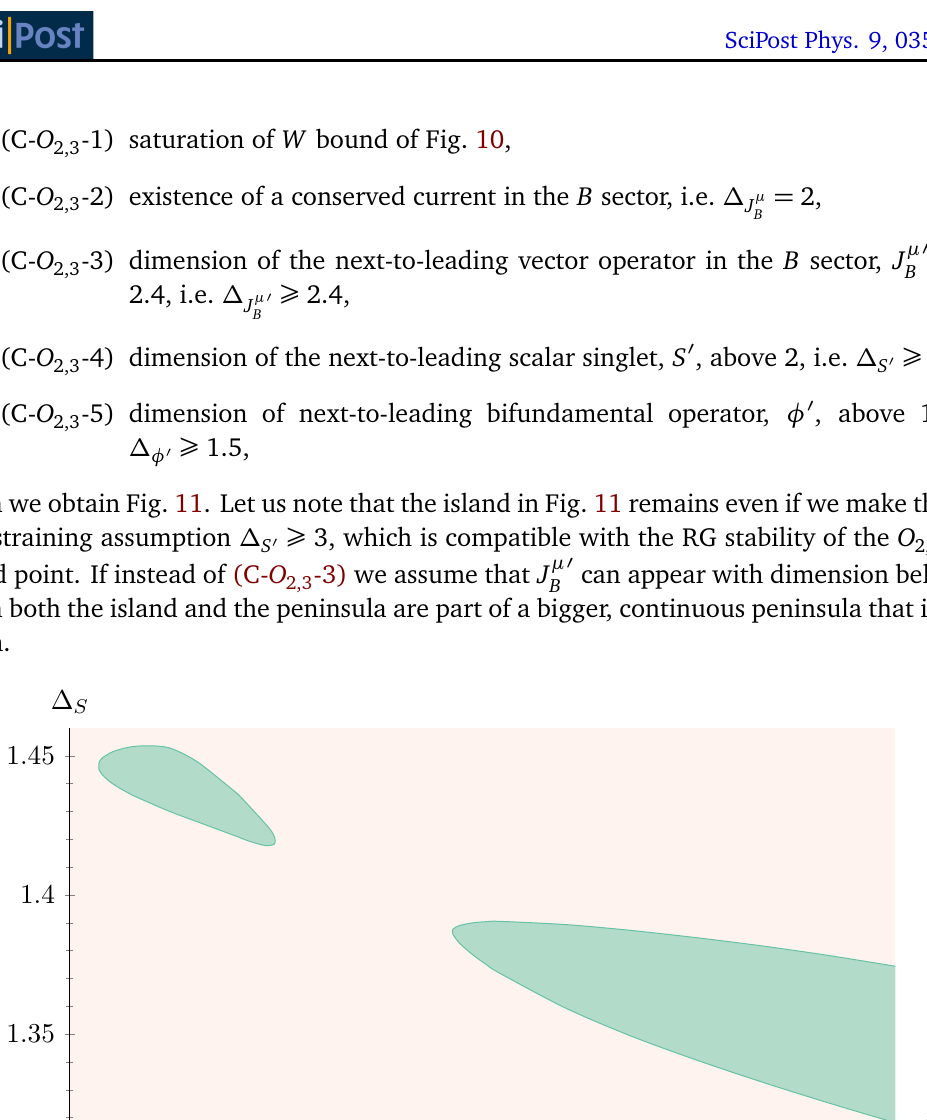
chiral fixed point, obtained 2,3